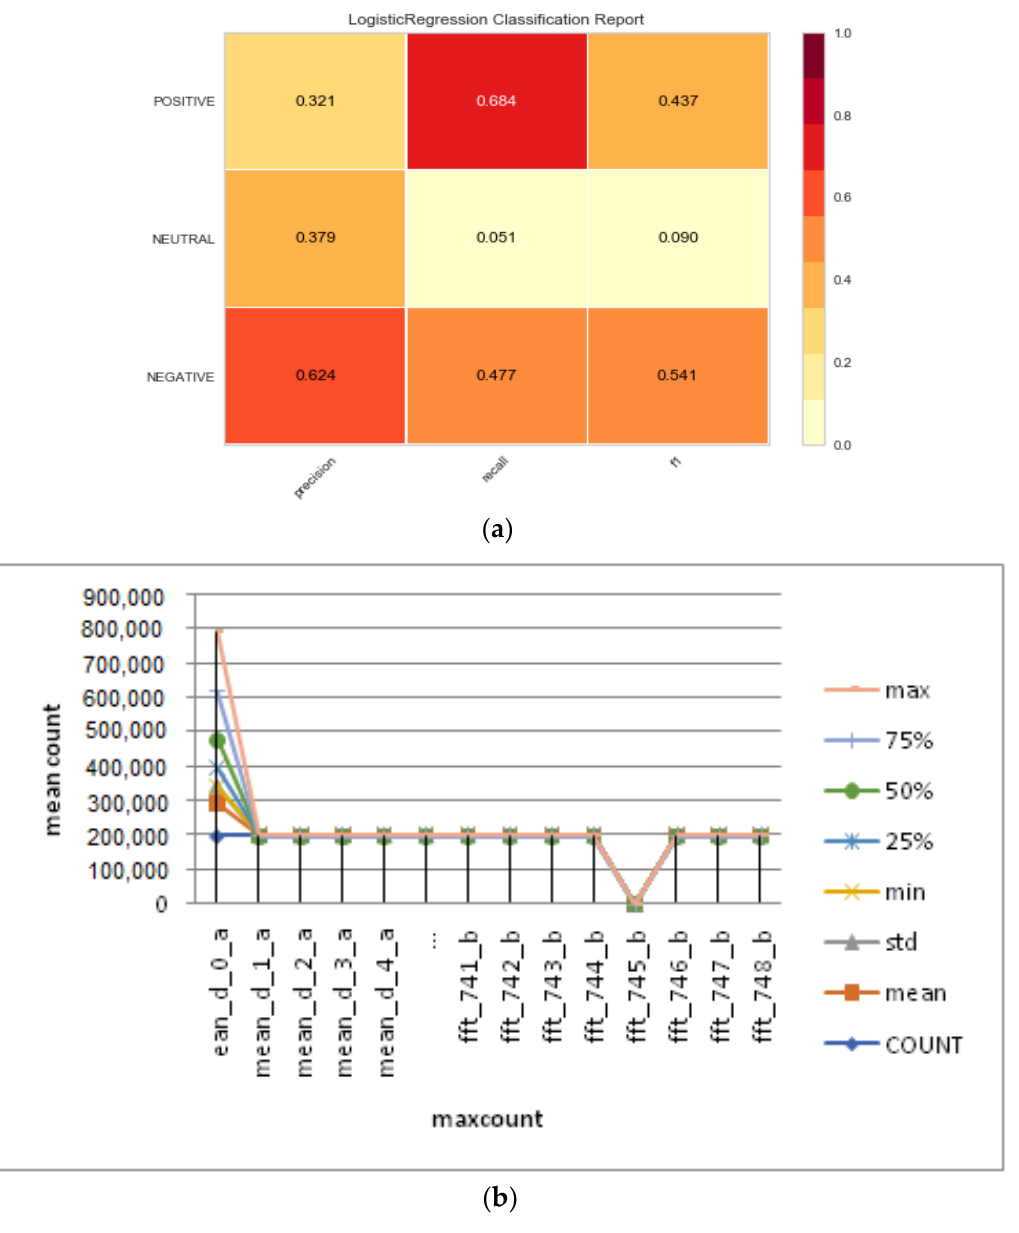
Figure 10. ( a )confusion matrix of DEAP DATASET ( b ) mean count validation on result.